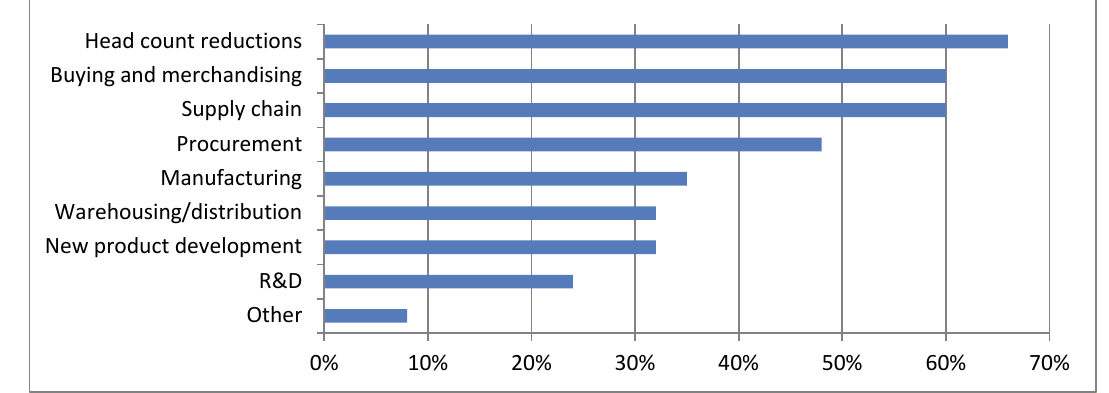
Fig. 3. Areas for saving